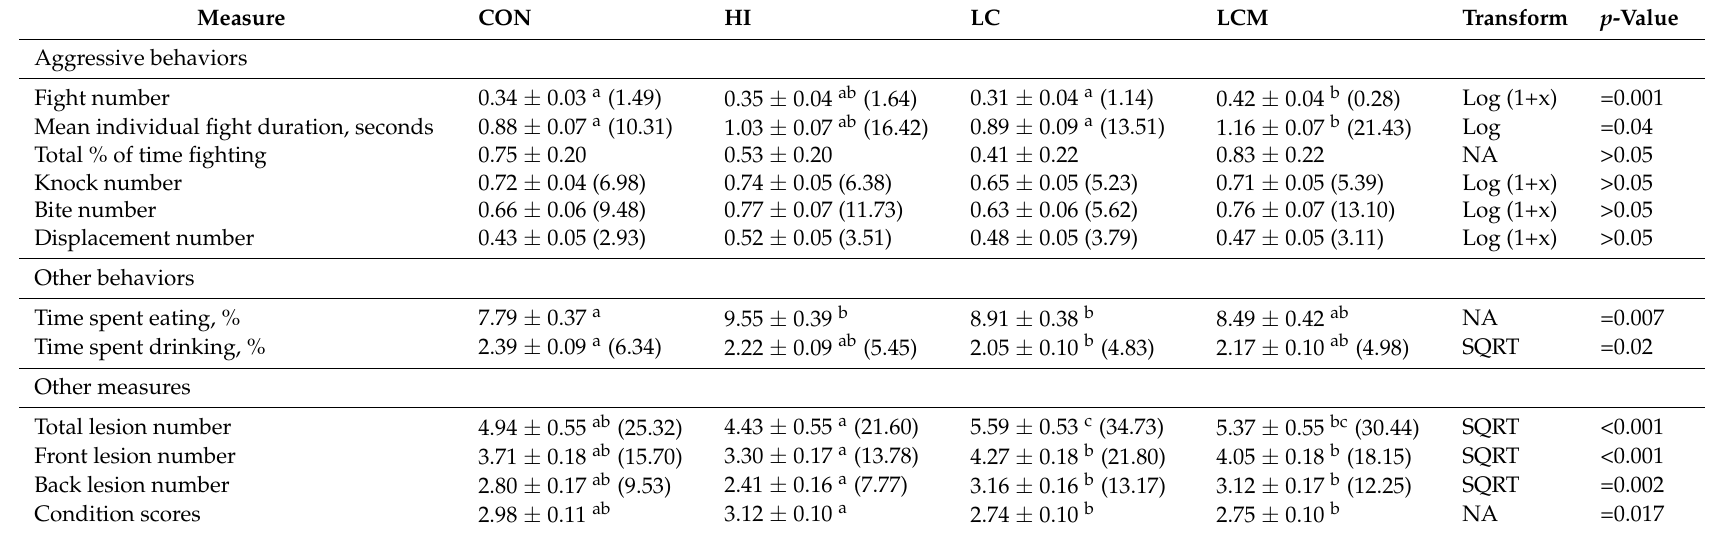
Table 3. Effect of feeding and fiber level at mixing on the number of or percentage of total time spent in certain aggressive and non-aggressive behaviors and other variables associated with these behaviors, in group housed gestating domestic sows given a control diet (CON), high intake diet (HI), lignocellulose before and after mixing (LC), and lignocellulose from mixing (LCM) 1,2